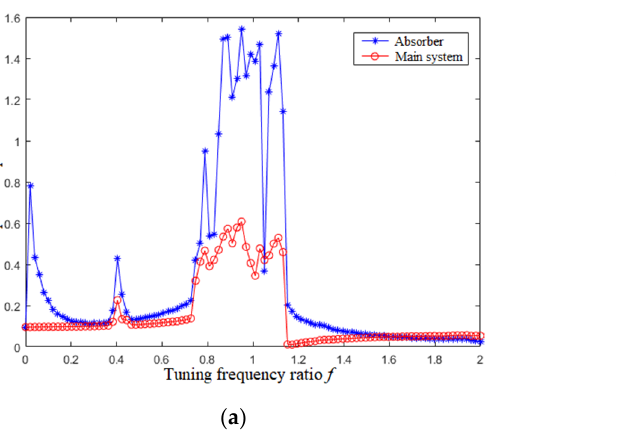
Figure 10. Response amplitude and phase diagram of two vibrators in the case of off-resonance ω = 1.6. ( a ) Response amplitude; ( b ) Phase diagram ( f = 0.9).